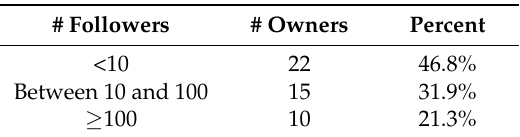
Table 5. The number of GitHub users following curation repository owners prior to the creation of curation projects.